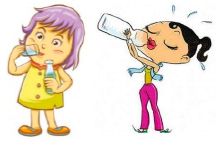
Figure A3. Emotion understanding—Coco drinking water.